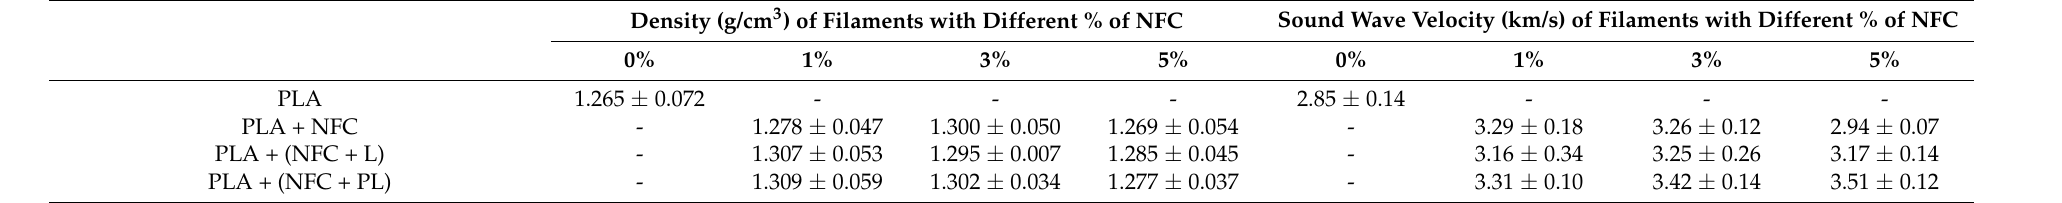
Table 2. Density and sound-wave velocity; mean value ±